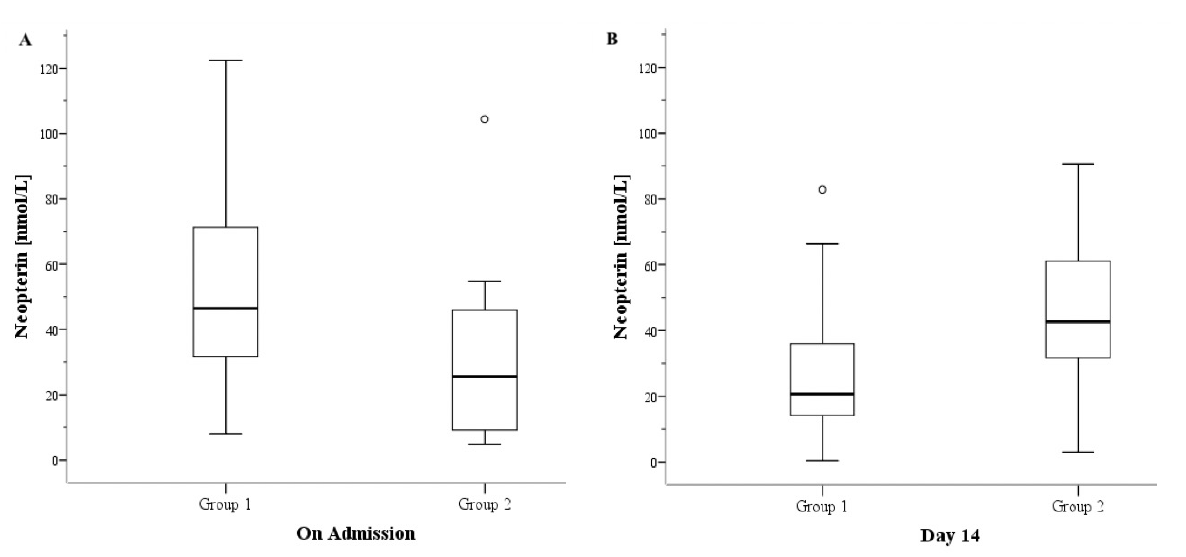
Figure 1: Comparison of serum neopterin concentrations between in groups classified according to disease course on admission day (A) and on Day 14 (B). Group 1, the patients recovered quickly; Group 2, the patients worsened progressively . The upper and lower portions of the boxes indicate the 25 th and 75 th percentiles, respectively. Horizontal lines within the boxes indicate the 50 th percentile (median). p < 0.05 differences between the groups.